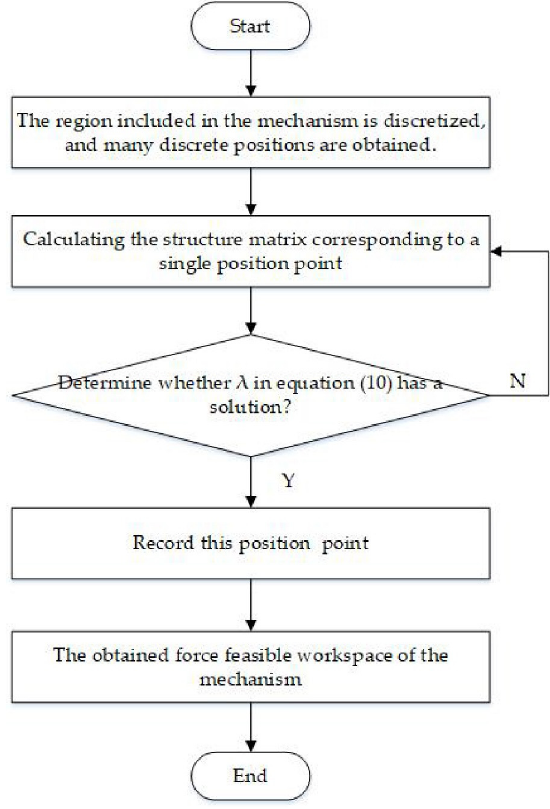
Figure 3. Solution algorithm flow of force-feasible workspace.